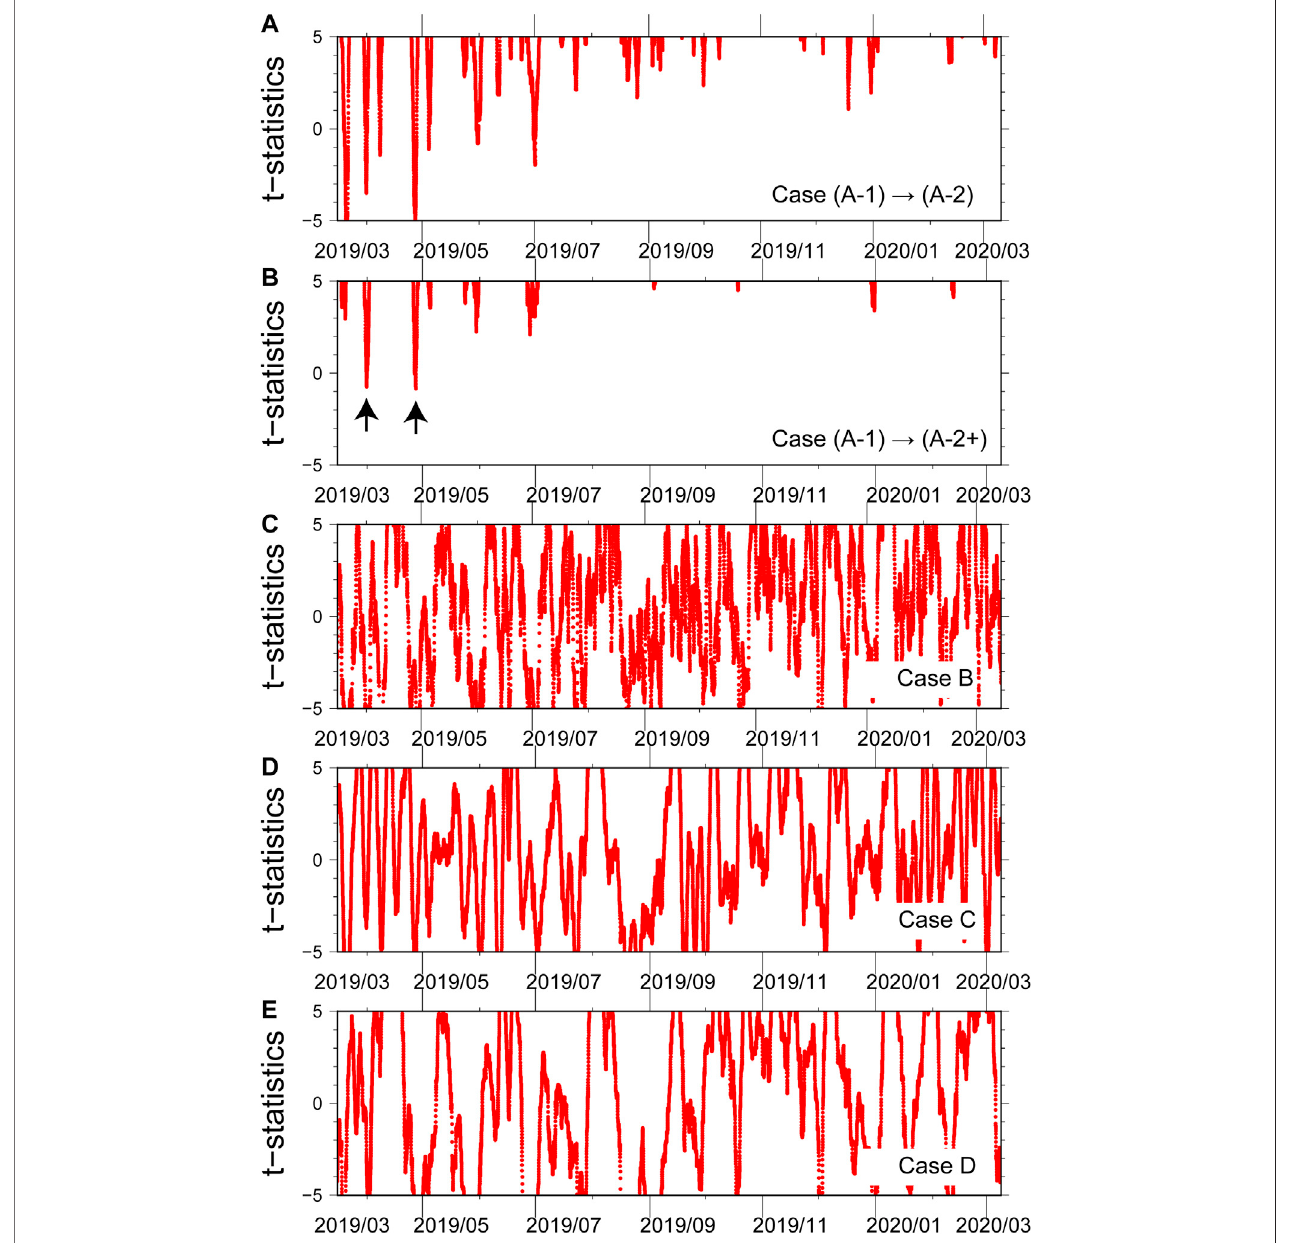
FIGURE 8 | Time history of t-statistics in Eq. (3) for each Case. Horizontal axis is origin time of fi tting time window. Positive value of t -statistics means regression linesexplain crustal deformation componentdueto SSE better than unrecognized fl uctuation. Vertical arrows indicate the minimum value of t -statistics for Case (A-1) to (A-2+), where corresponding time windows are indicated by two pairs of vertical dotted lines in Figure 7 .